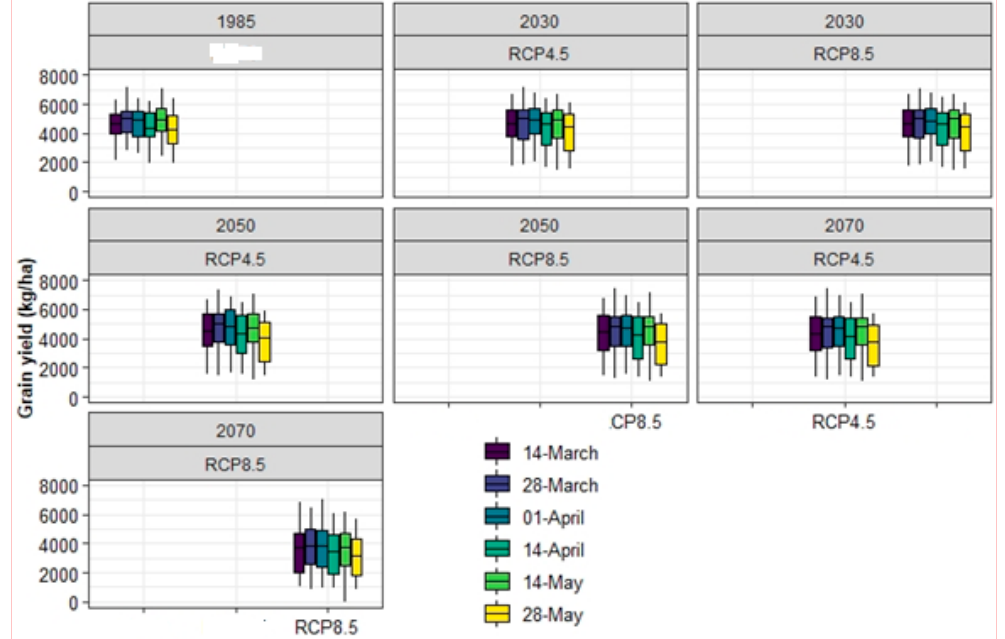
Figure 12. Grain yield of wheat (cv. Wedgetail) for different sowing times, emission scenarios, and projection periods.